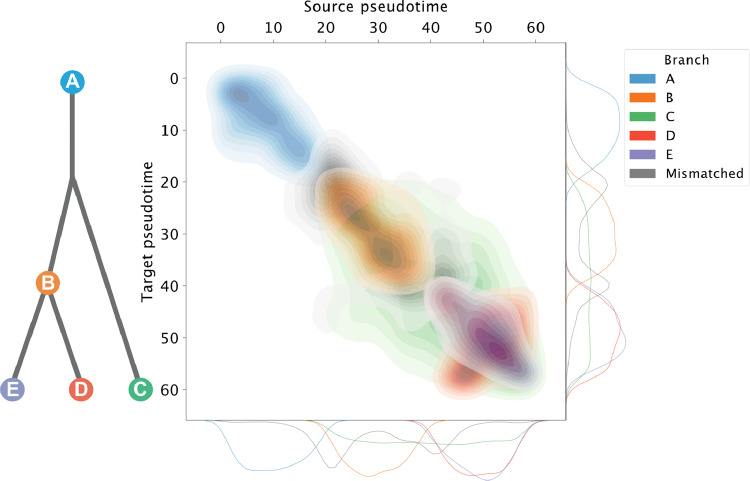
Evaluation of cross-technology cell matches made by SCIM on the simulated data. The tree defining the temporal branching process underlying the simulated data is shown on the left. Cells are matched across datasets pairwise using the bipartite matching scheme and the results are depicted on the right hand-side. The Results are shown as a density plot of pseudotime values across matched cells between the source technology (x-axis) and the target technology (y-axis). Cells matched to the same branch label are colored according to the branch-color scheme (accuracy: 86%), while mismatches are depicted in gray and appear mostly in the branching points. Marginal distributions of cell pseudotime for each branch are shown at the bottom (source technology) and left (target technology) of the density plot. We report a correlation of 0.83 (Spearman) and 0.86 (Pearson) for pseudotime label pairs